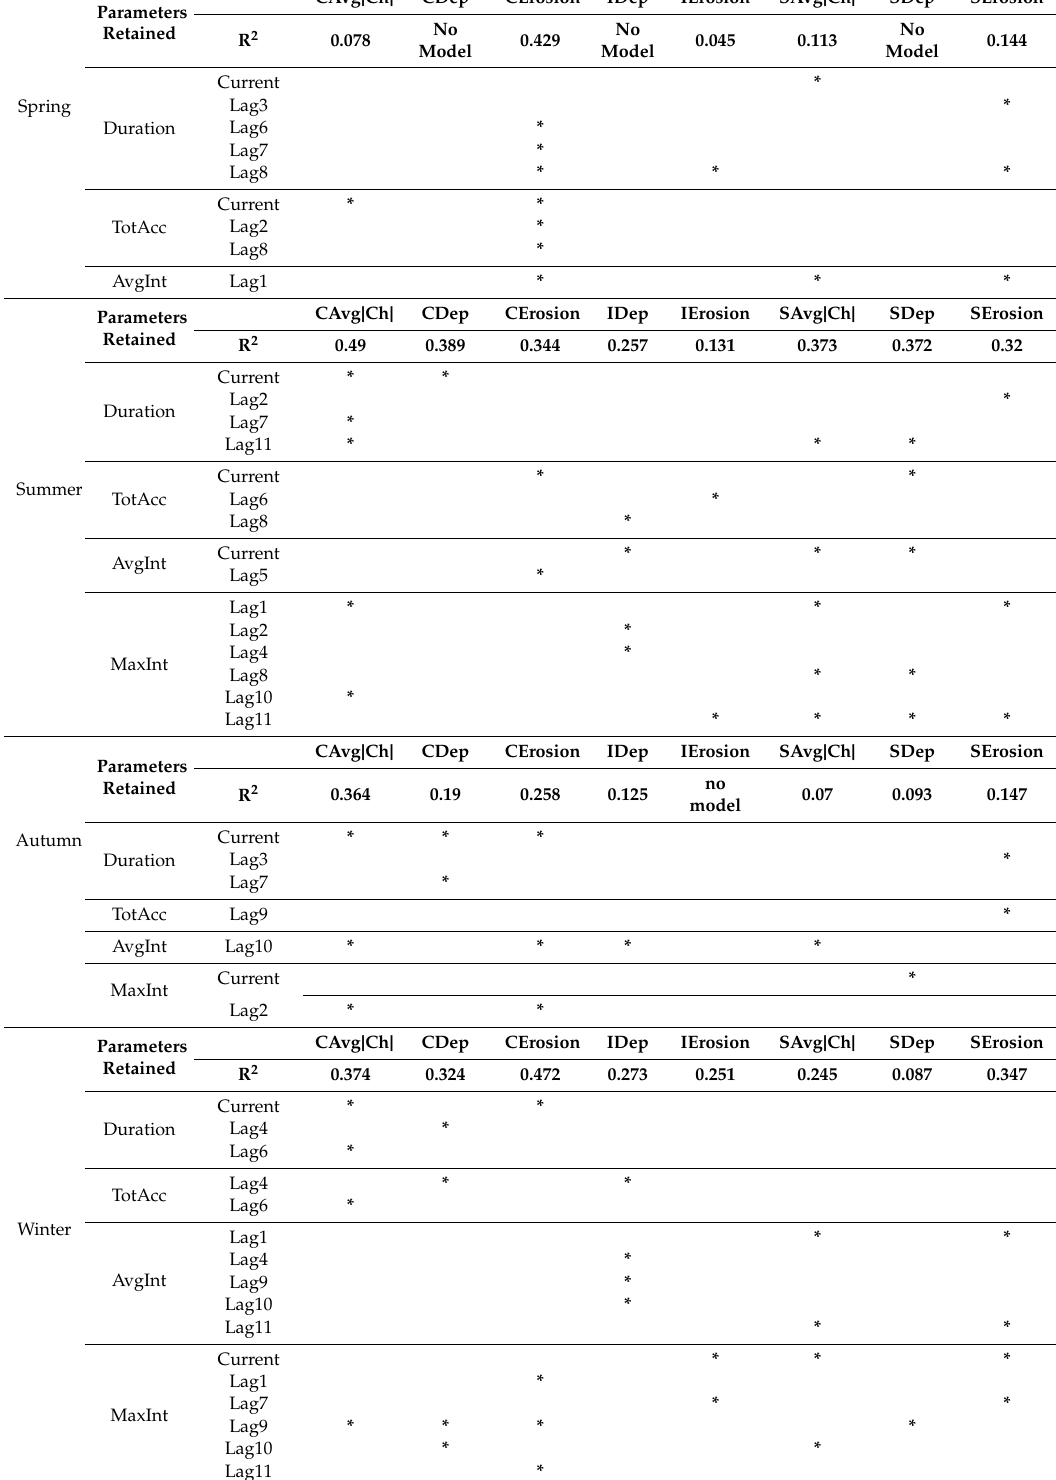
Table 5. Parameters retained (indicated by *) in seasonal Ordinary Least Squares regression models of erosion variables (dependent variables) using lagged precipitation parameters (independent variables) Duration (min), Total Accumulation (TotAcc (mm)), and Average and Maximum Intensity (AvgInt and MaxInt, respectively (mm / min)). C, channel; I, interfluve; S, sidewall. Each column represents a separate